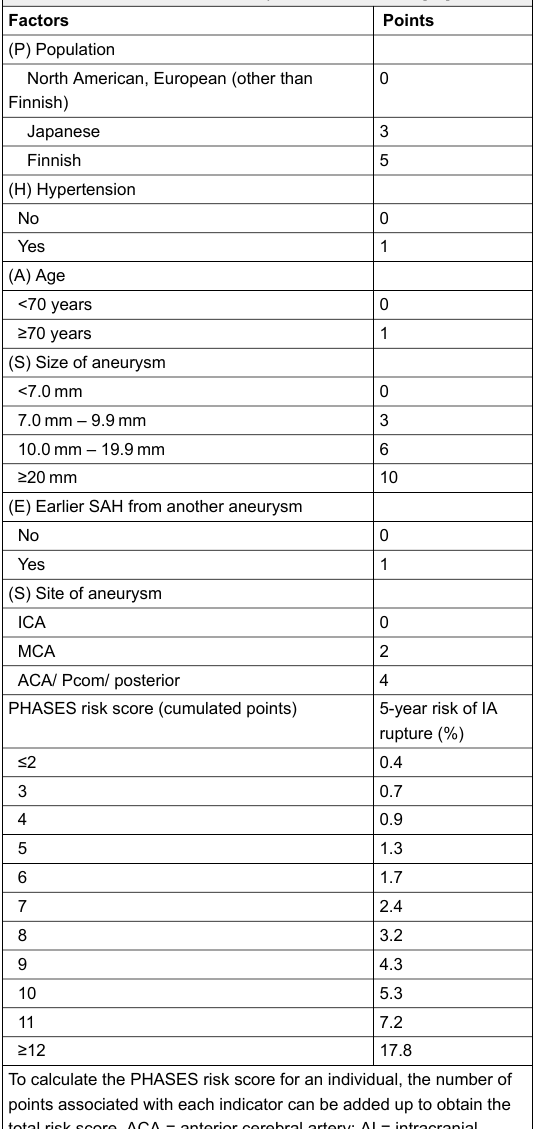
Table 1: PHASES score for UIA rupture risk estimation